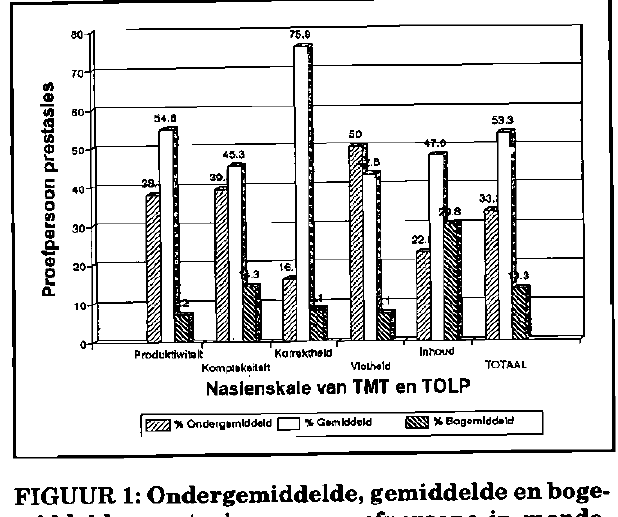
TABEL 2. Dataverwerking van toetsresultate